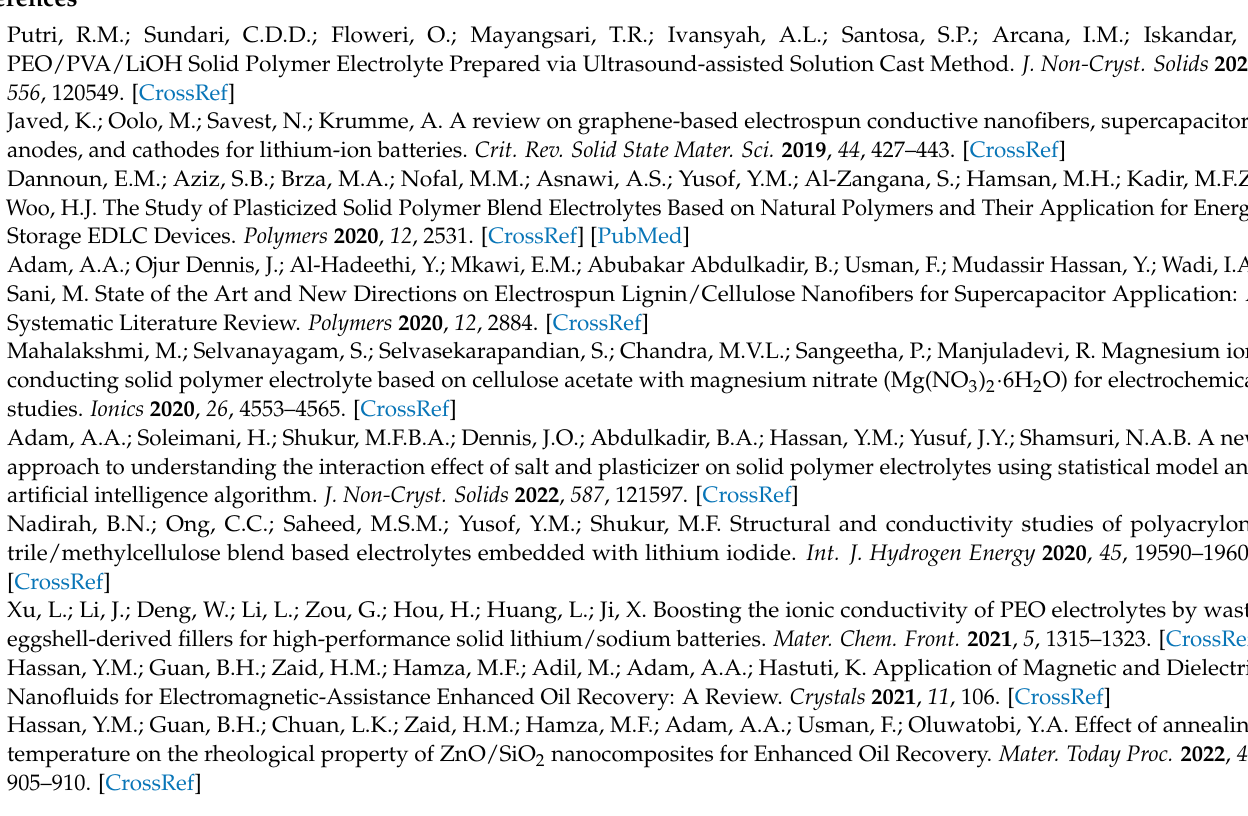
ent manipulations. Figure S3: Nyquist plots of MC/PVP polymer blend samples. Figure S4: Nyquist plots of other MC/PVP/K 2 CO 3 SPEs. Figure S5: Nyquist plots of other MC/PVP/K 2 CO 3 /EC SPEs. Table S1: Band assignment for MC/PVP polymer blend. References [81–85] are cited in the Supplementary